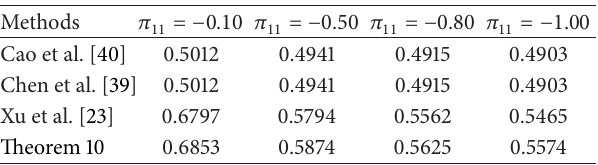
Table 3: Maximum upper bound of 𝑑 2 with 𝜇 = 0 and different parameter 𝜋 11 .